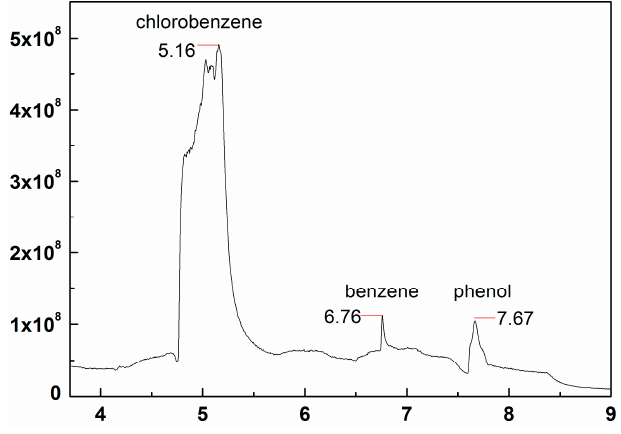
Figure 9. The Chlorobenzene intermediates during the Fe-Cu/biochar treatment.